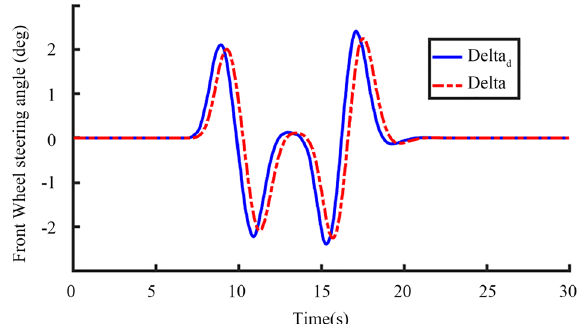
Figure 20. Desired front wheel angle and actual front wheel angle change with time.